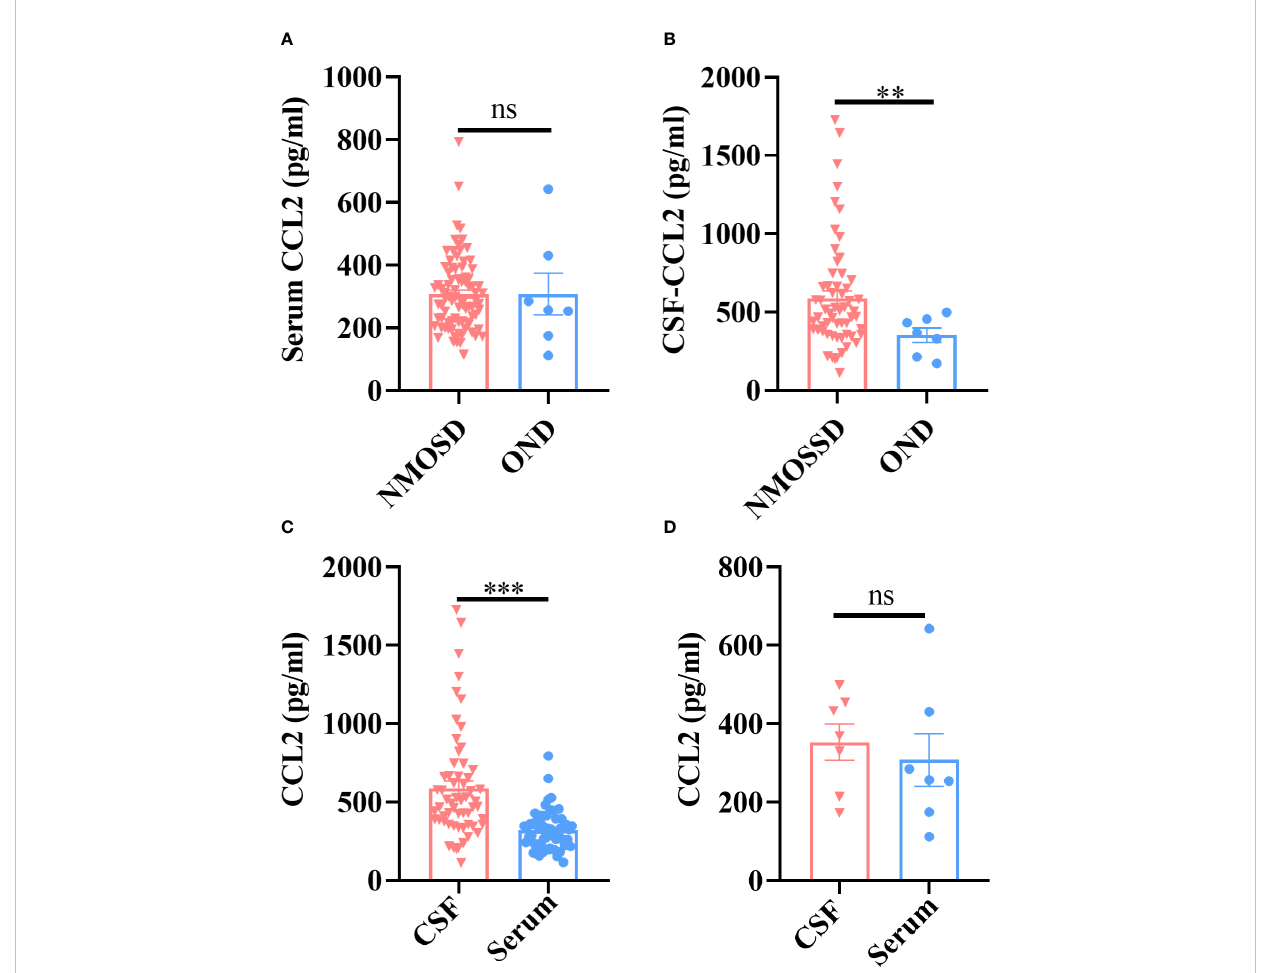
FIGURE 1 Patients with NMOSD and OND had their CCL2 levels in their serum and CSF tested by the Ella ® device (Protein Simple). Paired serum and CSF samples were available from 59 patients with NMOSD and seven patients with OND. (A) There were no signi fi cant differences in the serum CCL2 levels between the NMOSD and OND groups. (B) CCL2 levels in the CSF were noticeably higher in individuals with NMOSD than in patients in the OND group. (C) In NMOSD patients, CCL2 levels were signi fi cantly higher in CSF than in matched serum samples. (D) In OND patients, there were no signi fi cant differences in the levels of CCL2 between the matched serum and CSF samples. Data are presented as the mean ± SE. ** p < 0.01; *** p < 0.001; ns, not signi fi cant ( p >